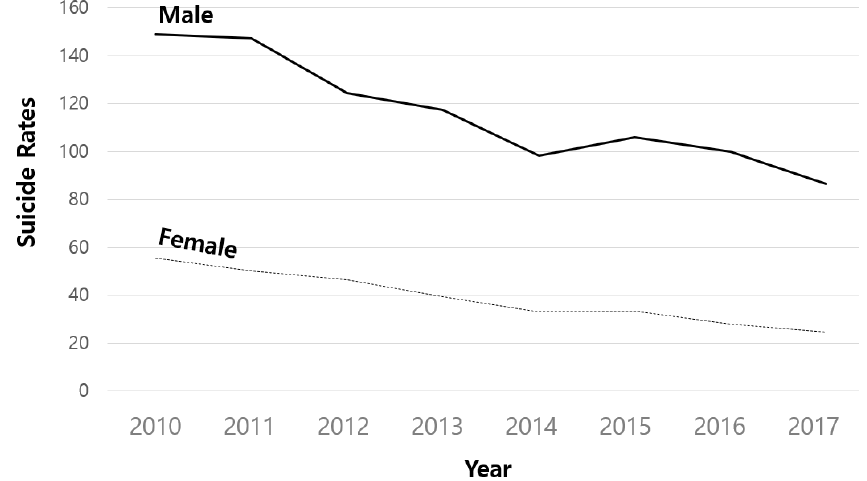
Figure 1. Suicide rate of older adults by gender.